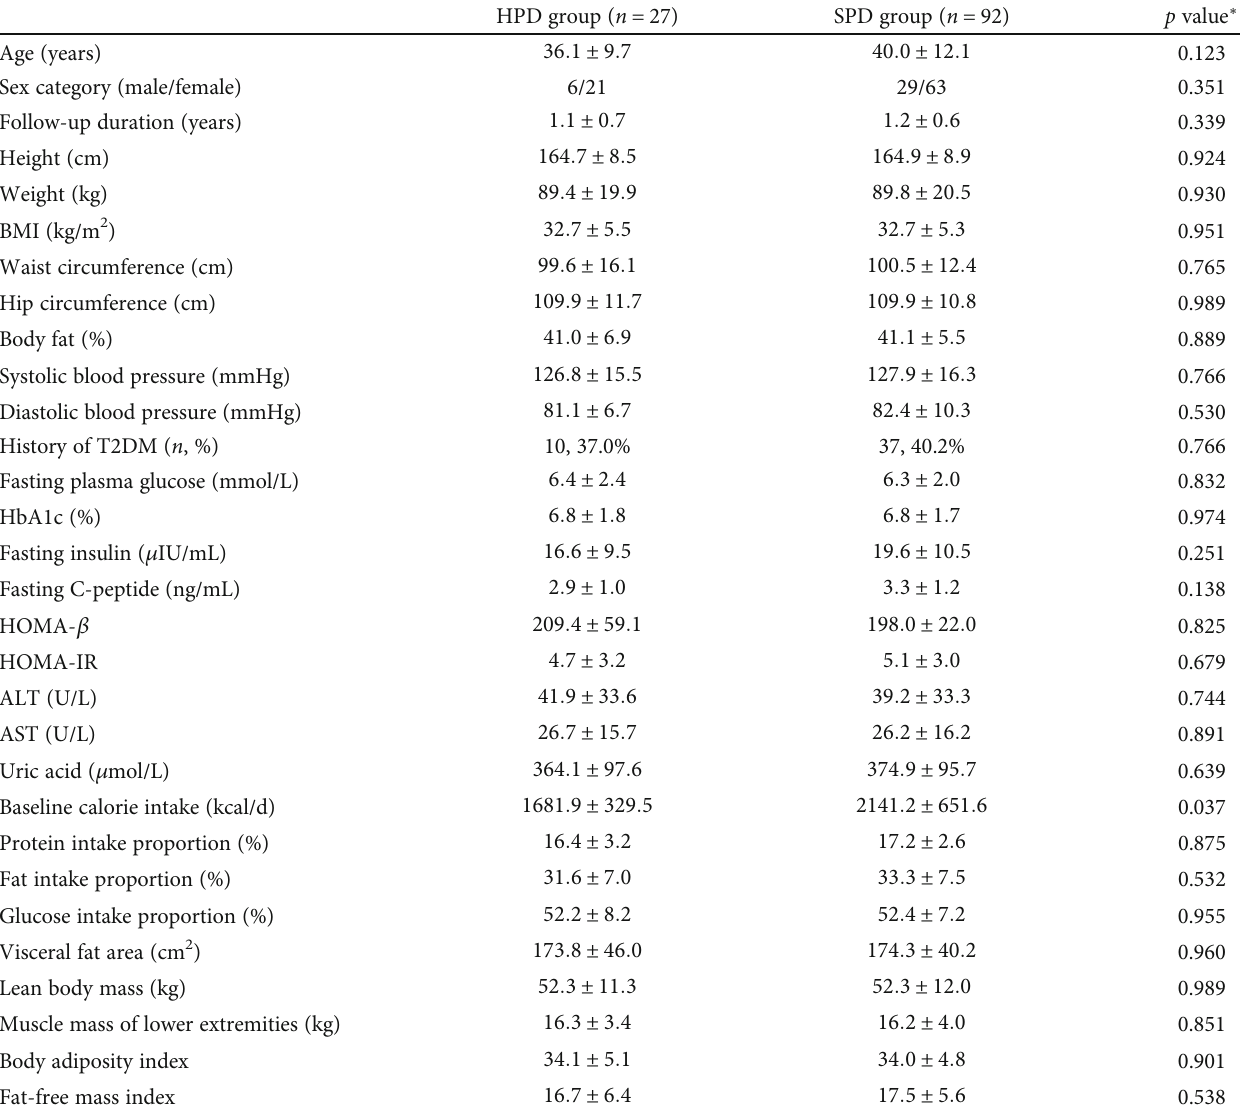
Table 1: Comparison of the demographic, anthropometric, and biochemical variables between SPD and HPD groups. HPD group ( n = 27